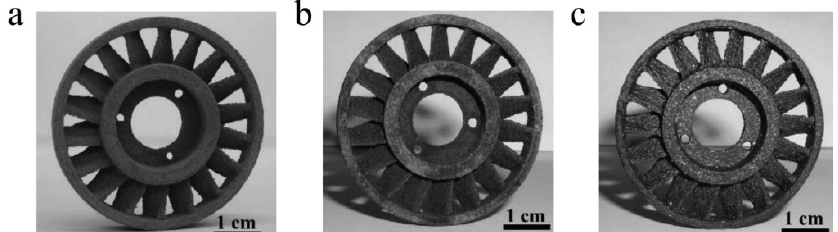
Fig. 24 SLA of SiC ceramic turbine wheel: (a) green body; (b) pyrolyzed body; (c) SiC body. Reproduced with permission from Ref. [76], © Elsevier Ltd. 2004.